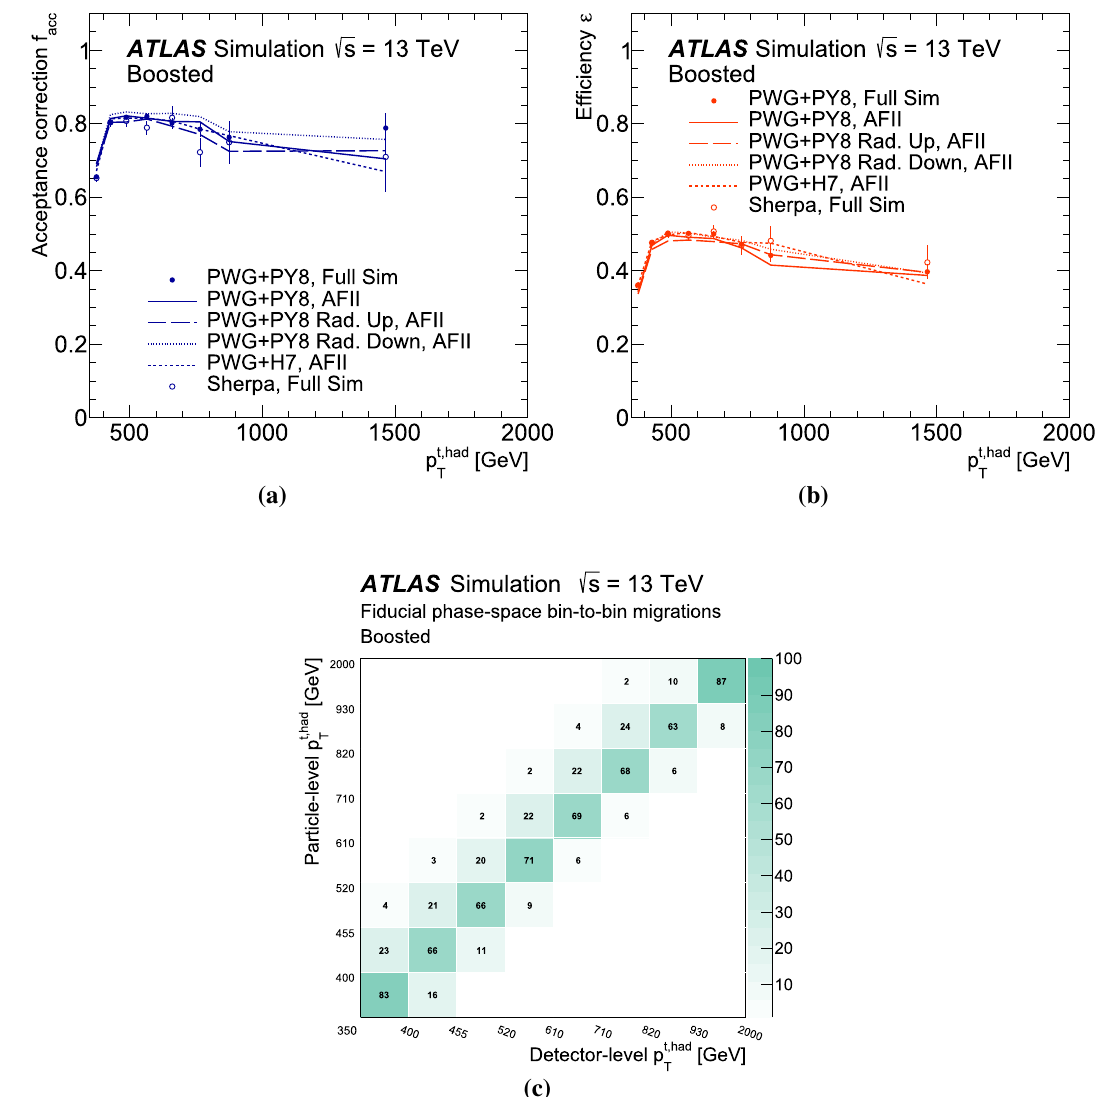
Fig. 14 The a acceptance f acc and b efficiency ε corrections (evalu- ated with the Monte Carlo samples used to assess the signal modelling uncertainties, as described in Sect. 9.2), and c the migration matrix